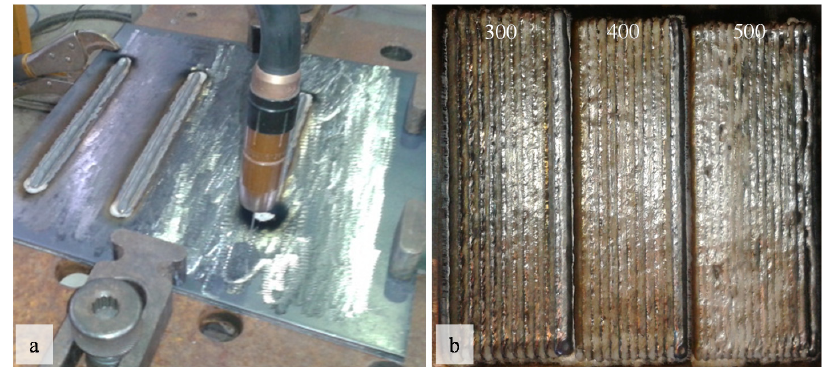
Figure 1. The deposition of FM60 plates at three travel speeds of 300, 400 and 500 mm/min: ( a ) the beginning of deposition process and ( b ) fabricated plates.